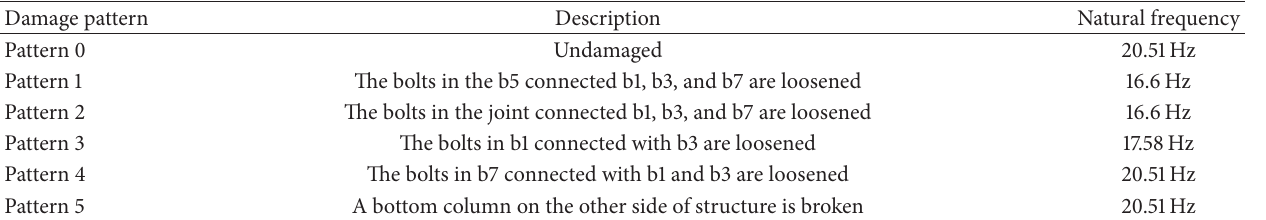
Table 6: The damage patterns of truss structure.